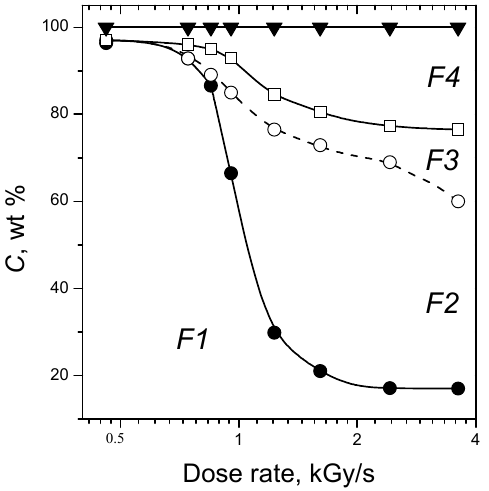
Figure 9. Influence of absorbed dose rate in M2 mode on content C of solid (F1), liquid organic (F2), aqueous (F3) and gaseous (F4) fractions in products of microcrystalline cellulose distillation at dose 500 kGy.